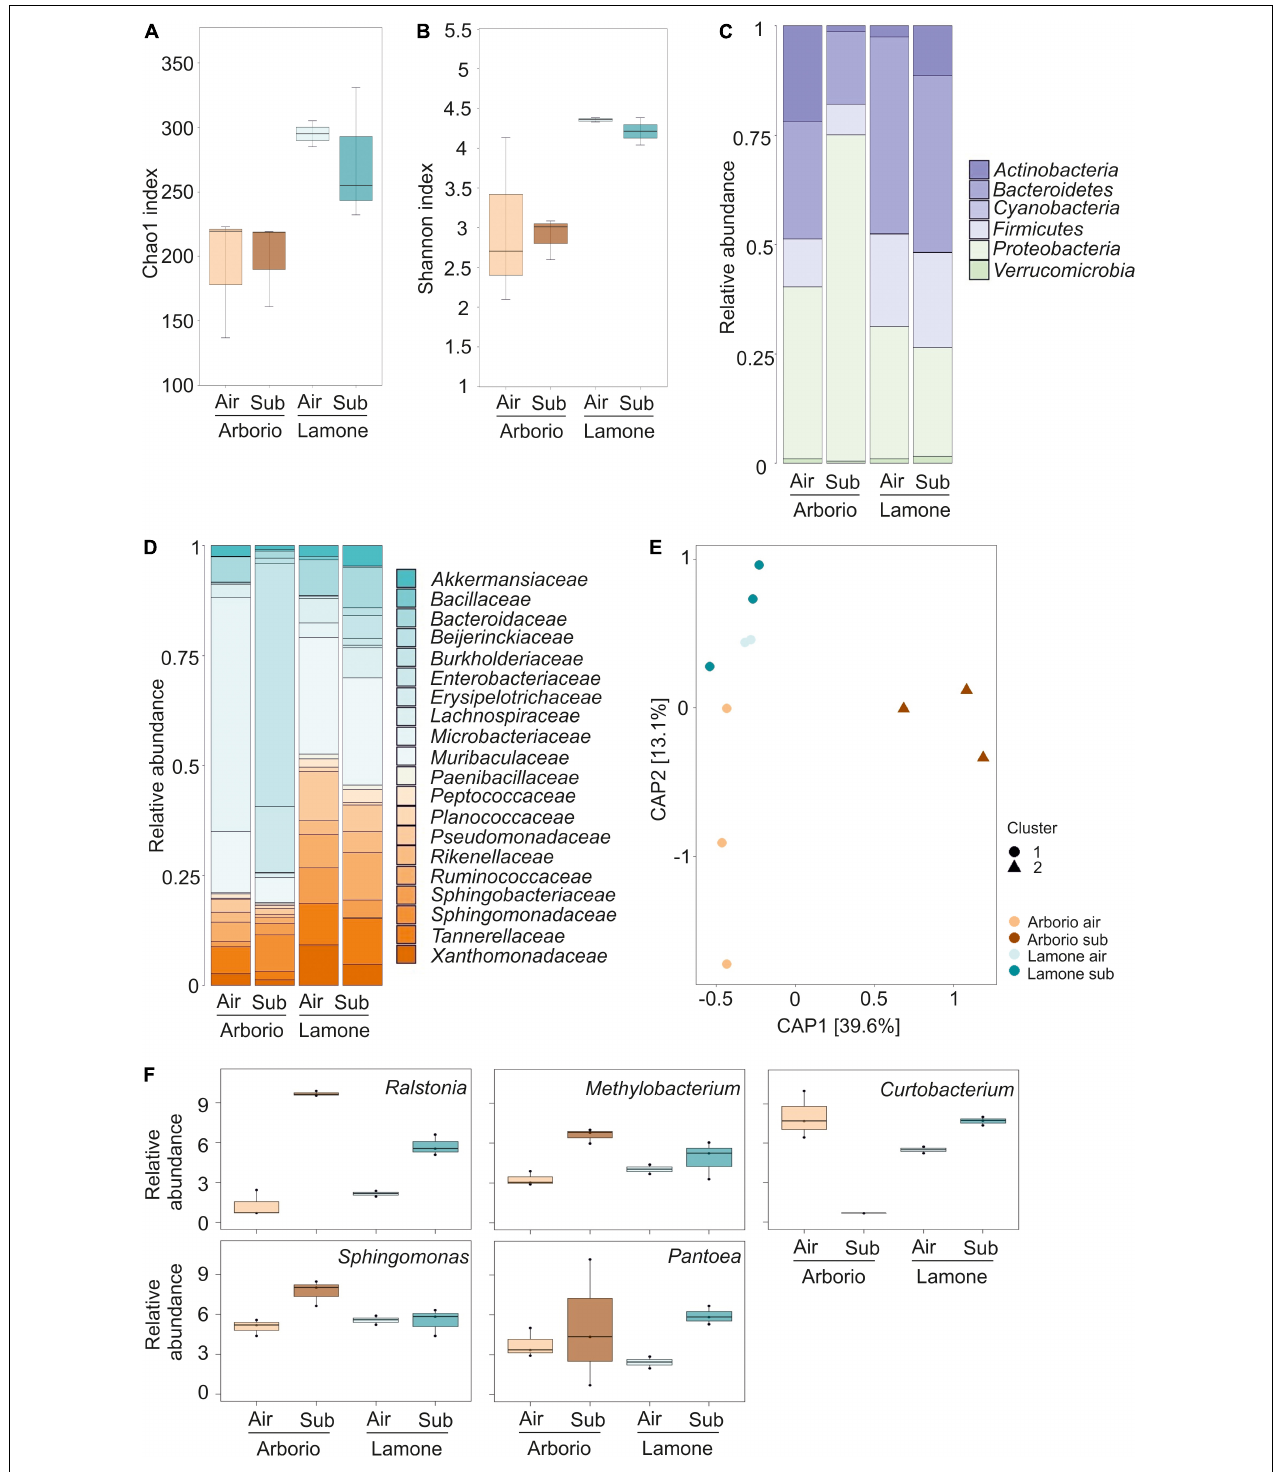
FIGURE 1 | (A) Chao1 index reflecting the OTU abundance. Kruskal-Wallis test p = 0.055 (B) Shannon index reflecting the OTU diversity. Kruskal-Wallis test p = 0.073. (C) Relative abundance of the dominant phyla of Arborio and Lamone rice seedlings. (D) Relative abundance of the most abundant families of Arborio and Lamone rice seedlings. Only phyla and families showing a minimum average relative abundance of 20% are included in the figures, in which the average of the three replicates is represented. For Lamone air, two replicates are represented. (E) Canonical analysis of principal coordinates of the Bray-Curtis distance. (F) Relative abundance of the significant genus (FDR < 0.05) obtained grouping all the OTUs likely belonging to that single genus.